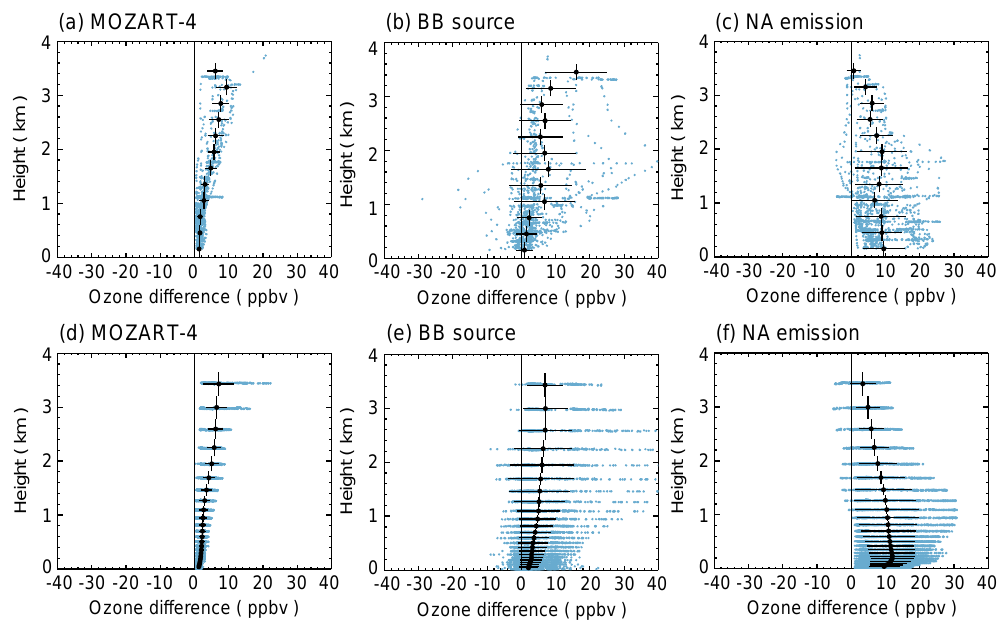
Fig. 16. Vertical distributions of O 3 difference between two simulations. “MOZART-4” = MOZART BB – WRF60k BB, “BB source” = WRF60k BB – WRF60k, and “NA emission” = WRF60k – control run, indicating the impact of chemical initial/boundary conditions by the MOZART-4 ( a and d ), biomass-burning source ( b and e ), and the North American anthropogenic/biogenic emissions ( c and f ) for the WP-3D (a–c) and DC-3 (d–f) flight tracks on 20 and 21 July. Binned height-intervals and corresponding mean and standard deviation are plotted.